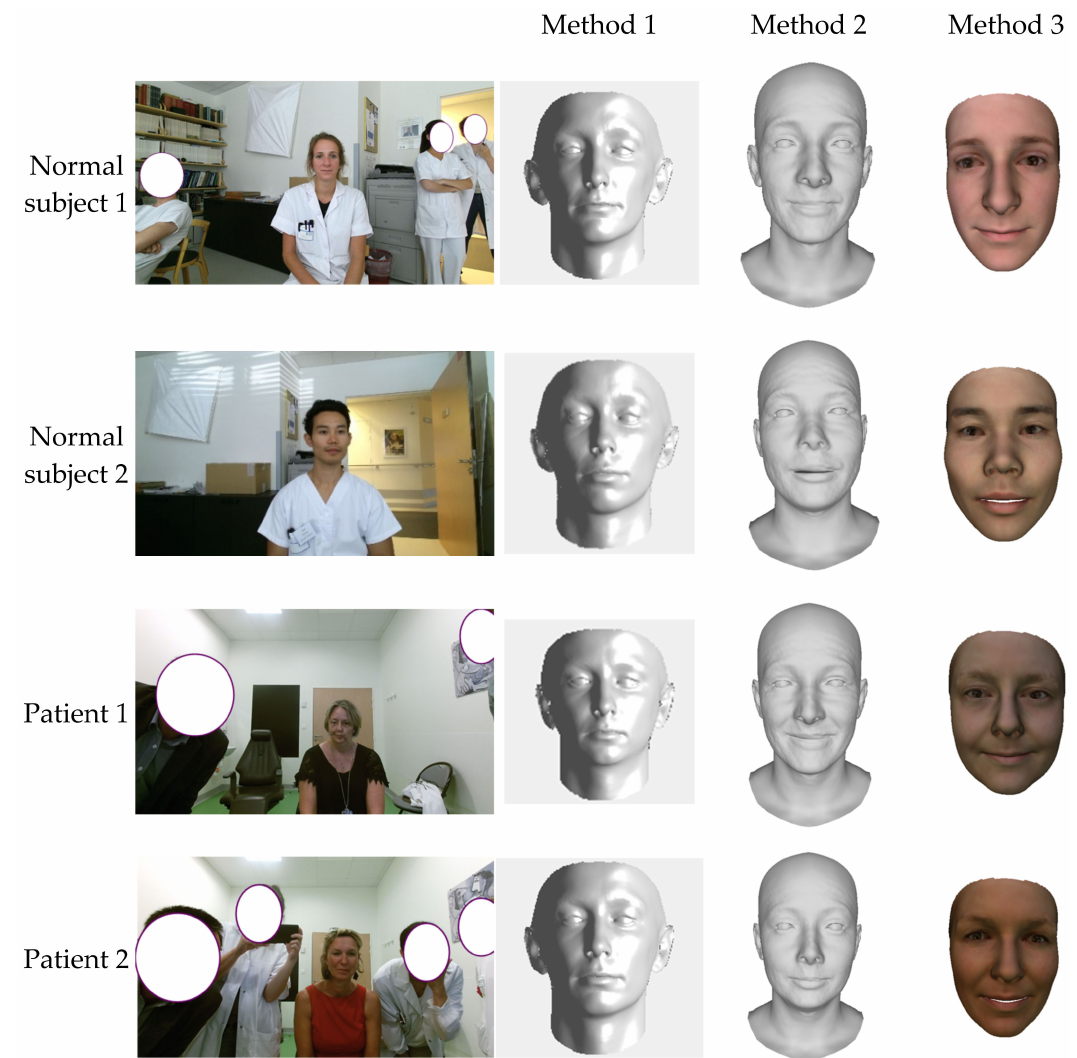
Figure 6. 3D face reconstruction from an input